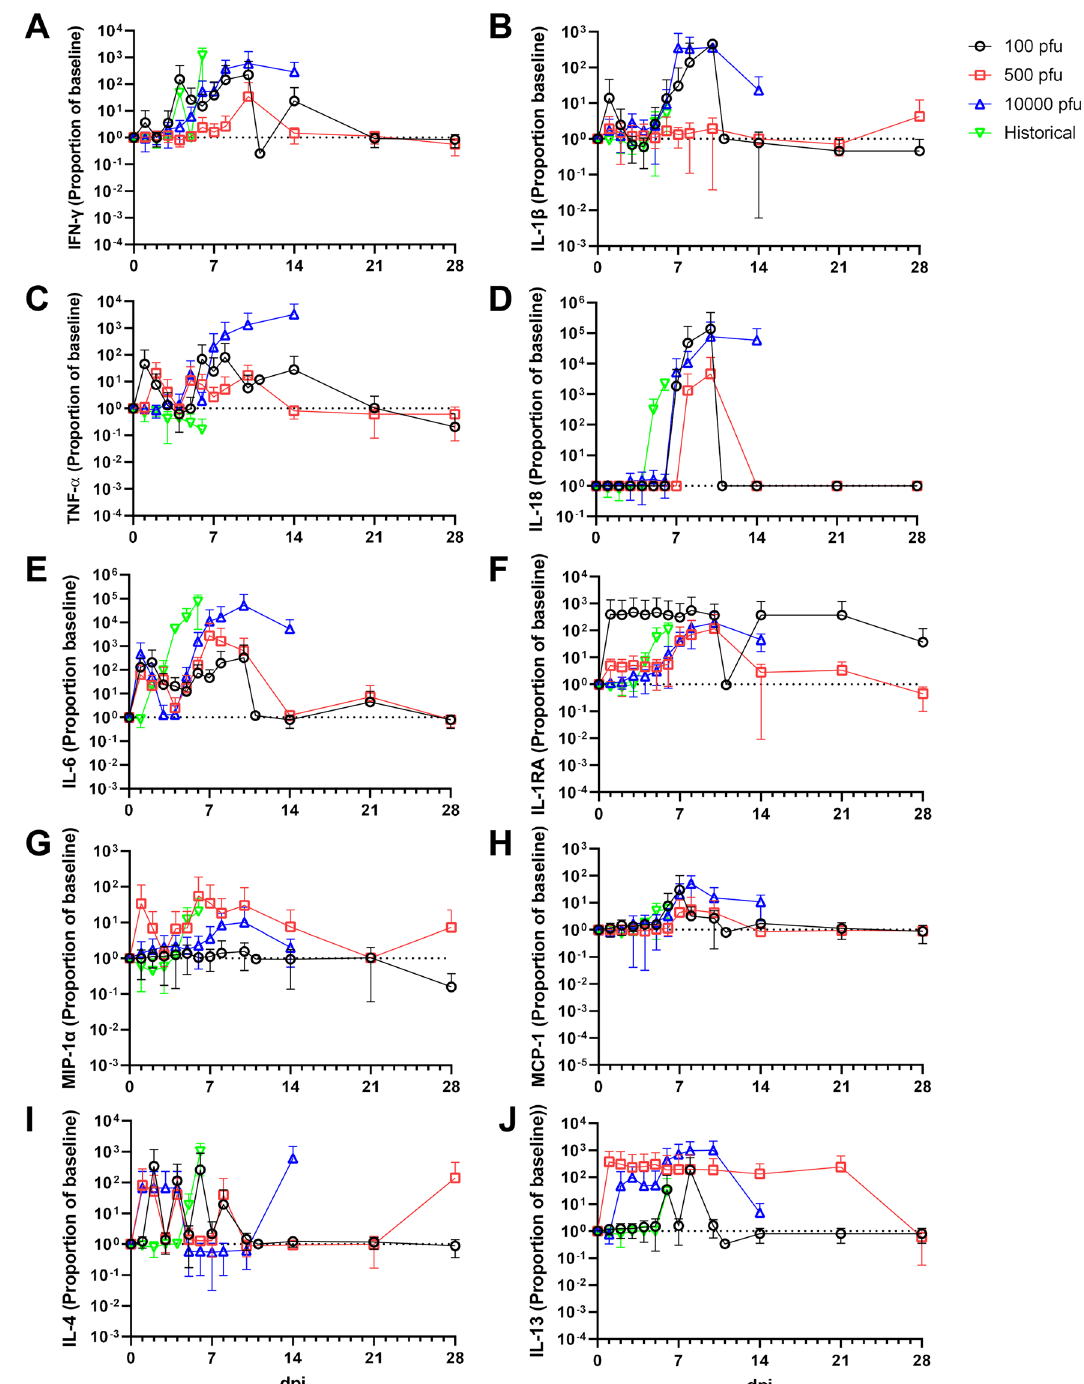
Figure 5. Circulating levels of inflammatory markers in EBOV-challenged macaques. Absolute values of each analyte measured for each subject at the indicated timepoints, and normalized to baseline (day 0/challenge) values. Shown is the average value for all animals in the indicated group. Data is shown as a proportion of baseline (set to 1, indicated by dashed horizontal line in each panel) to facilitate plotting on a log scale. Data from historical control animals inoculated i.m. with the homologous virus 40 were included for statistical purposes. ( A ) IFN-γ; ( B ) IL-1β; ( C ) TNF-α; ( D ) IL-18; ( E ) IL-6; ( F ) IL-1RA; ( G ) MIP-1α; ( H ) MCP-1; ( I ) IL-4; ( J ) IL-13. All assays were run in duplicate